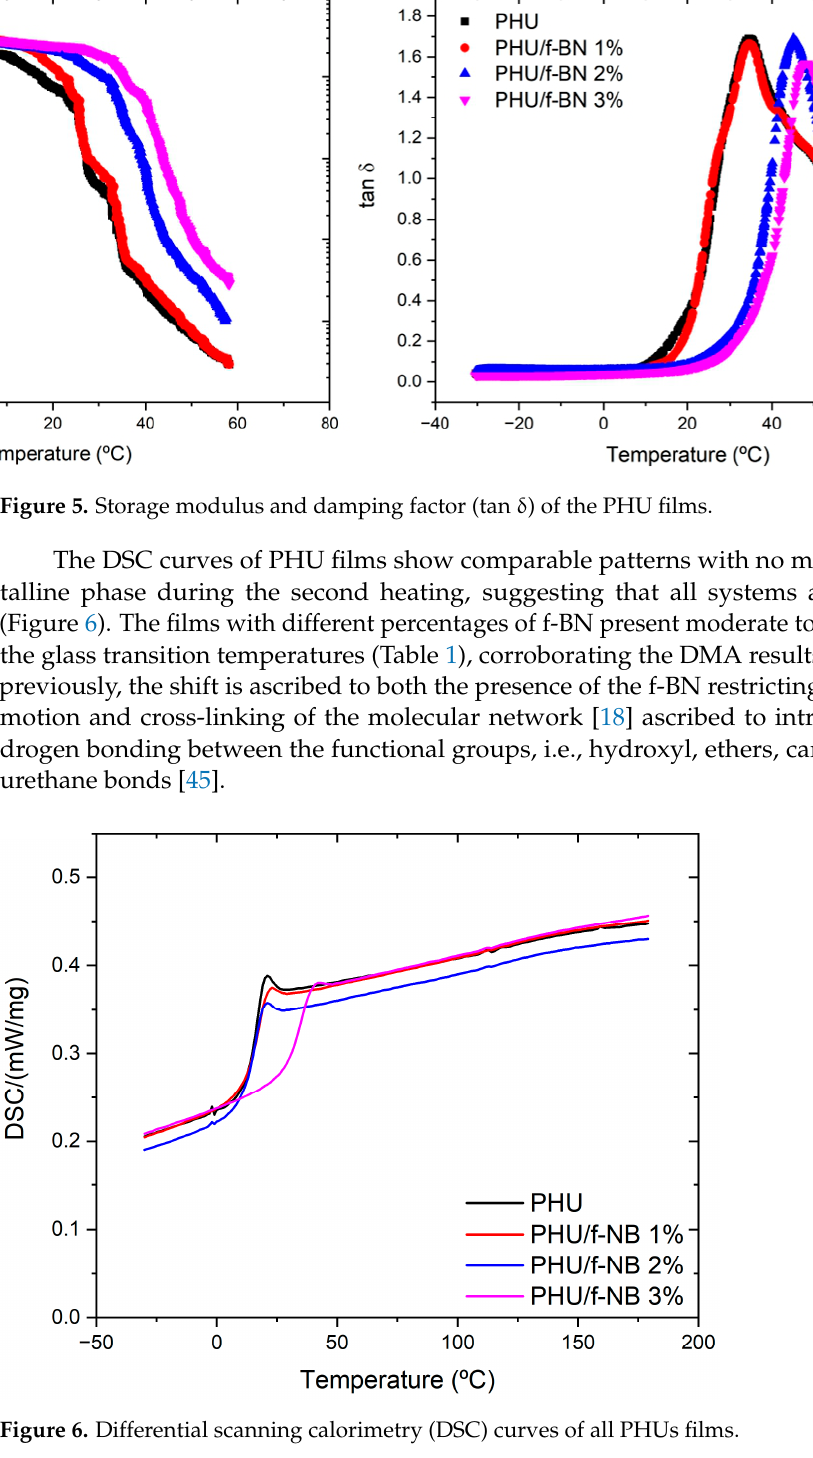
Figure 6. Differential scanning calorimetry (DSC) curves of all PHUs films. SEM images of PHU and PHU/f-BN composites are shown in Figure 7. Micrographs of the composites show no phase separation and agglomeration of f-BN, indicating the nanoparticles are well dispersed in the polymer matrix.